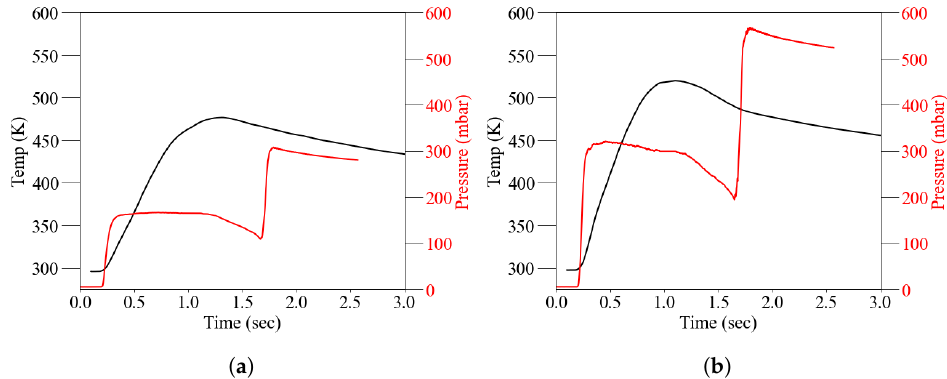
Figure 7. Comparing temperature at Mach 2 operation for ( a ) Lower pressure condition, 1.6/2.6 bar for Plenum/Charge Tank ( b ) Higher pressure condition, 3.2/4 bar for Plenum/Charge Tank.